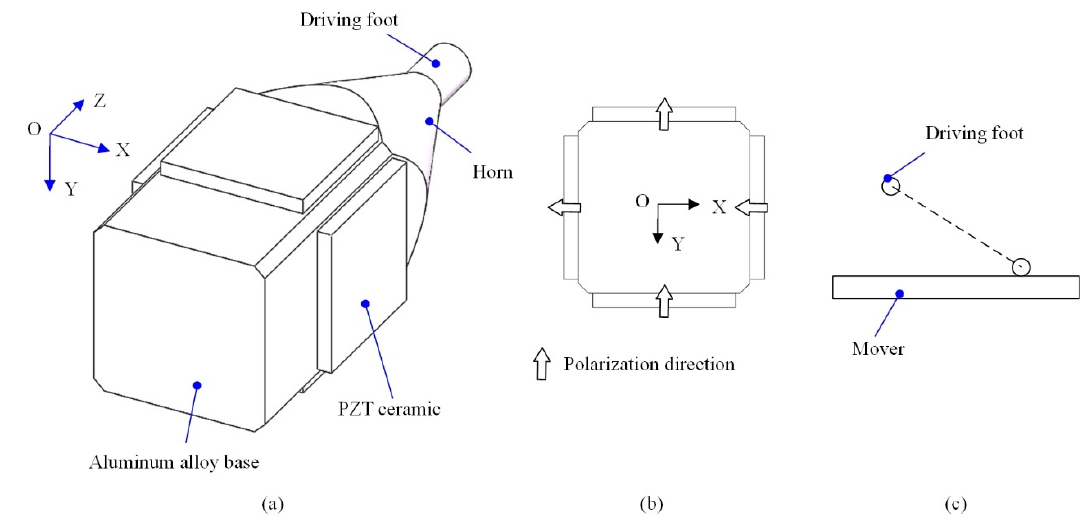
Figure 1. Structure and working principle of the proposed single-phase-driven ultrasonic motor: ( a ) structure, ( b ) polarization directions, ( c ) schematic diagram of driving trajectory.